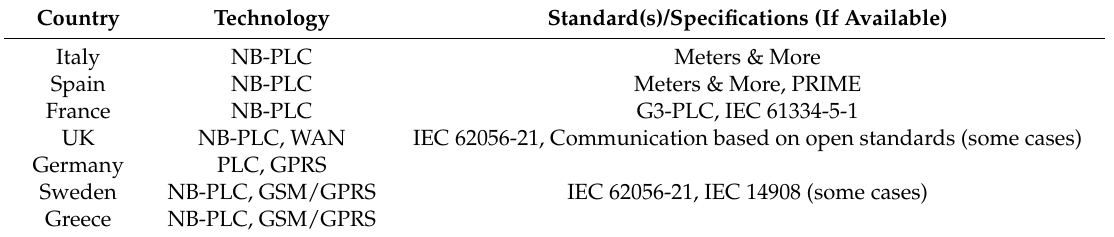
Table 2. Some of the technologies used by country for smart metering data